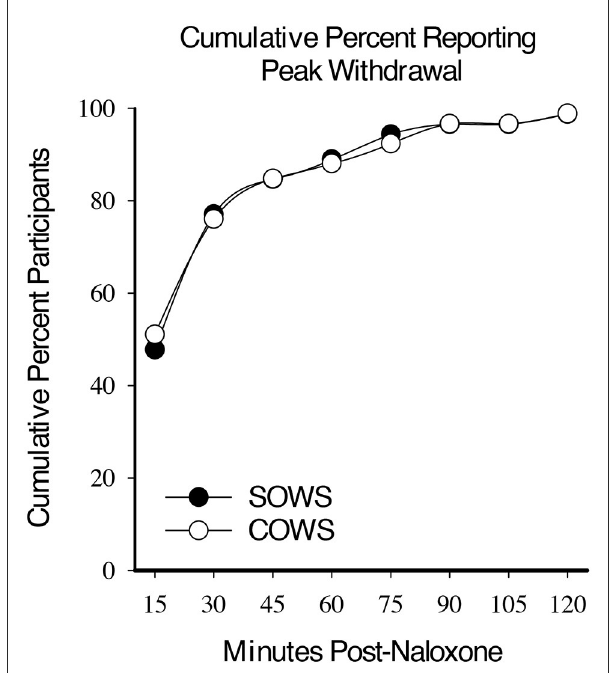
FIGURE1 Cumulative peak experience. Cumulative percentage of participants who reported peak self-reported (Subjective Opiate Withdrawal Scale; SOWS, filled circle) and observer-rated (Clinical Opiate Withdrawal Scale; COWS, open circles) scores at each 15-min timepoint post-naloxone (0.4mg intramuscular dose).